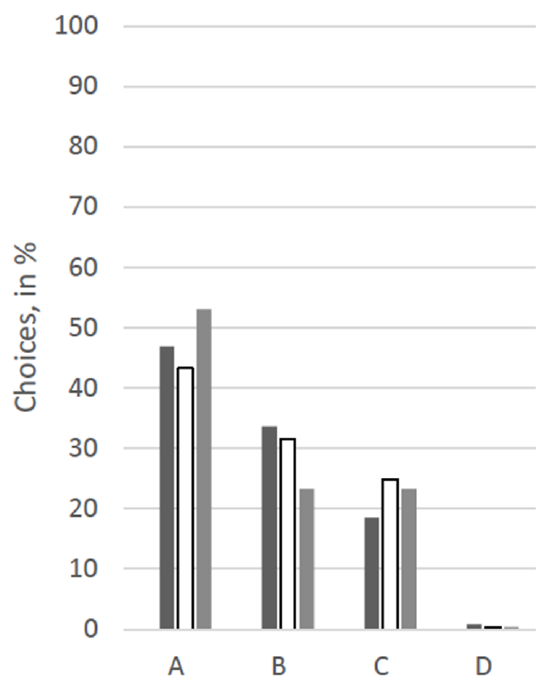
Figure 2. Answers for the scenario “11-year-old dog” in %. Legend: black: human medicine group; white: control group; grey: veterinary medicine group; A: Euthanasia tablet, B: Sedation tablet, C: Potentially curative tablet, D: No treatment.